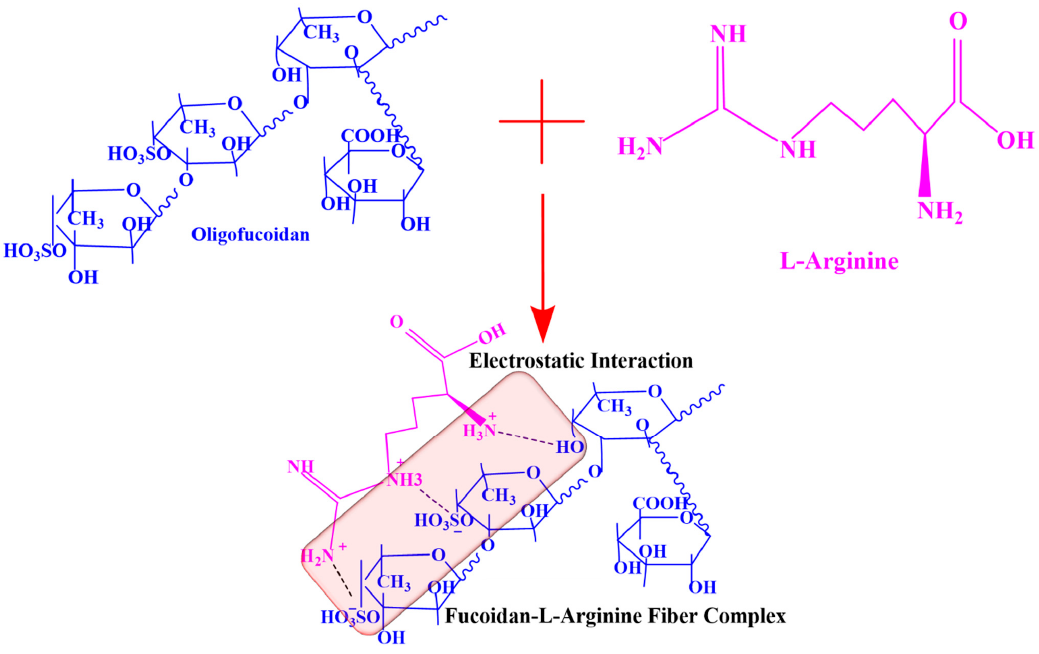
Figure 2. Schematic representation of the electrostatic interaction between fucoidan and L-arginine. 3.2. Morphology of the Fuc-L-Arg Fiber Complex and Its Impact on Cellular Uptake The morphologies of the pristine fucoidan, pristine L-arginine, and Fuc-L-Arg (1:1, 1:2.5, and 1:5) complexes were observed using FE-SEM. Both pristine fucoidan and L- arginine exhibited aggregate structures, whereas, in the case of Fuc-L-Arg, a porous sheet- interaction of the fucoidan sulfate group with the L-arginine amine group [12]. Further, the energy-dispersive X-ray spectroscopy confirmation of elements is presented in the sup- plementary data (S2). Fiber morphology plays a significant role in cellular internalization through vertical overlap with the cell membrane [36,37] (Figure 3).